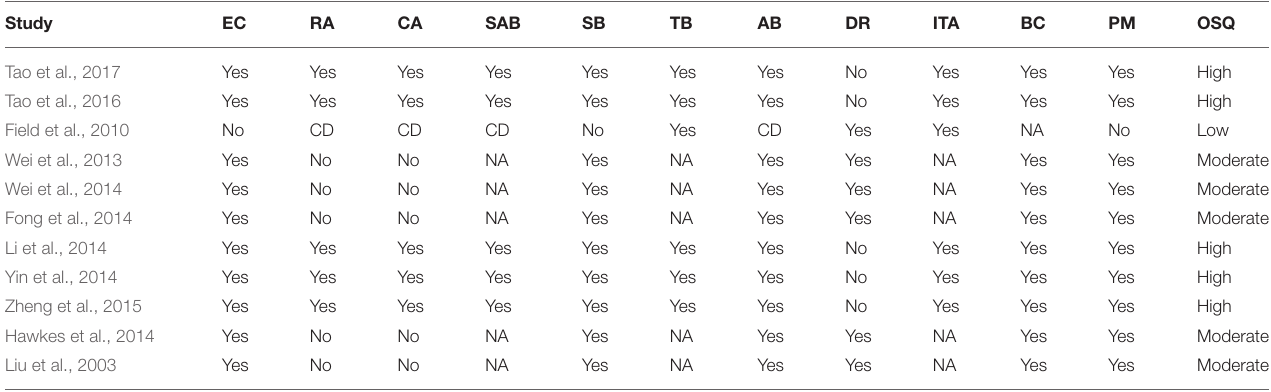
TABLE 2 | Quality assessment of reviewed studies.